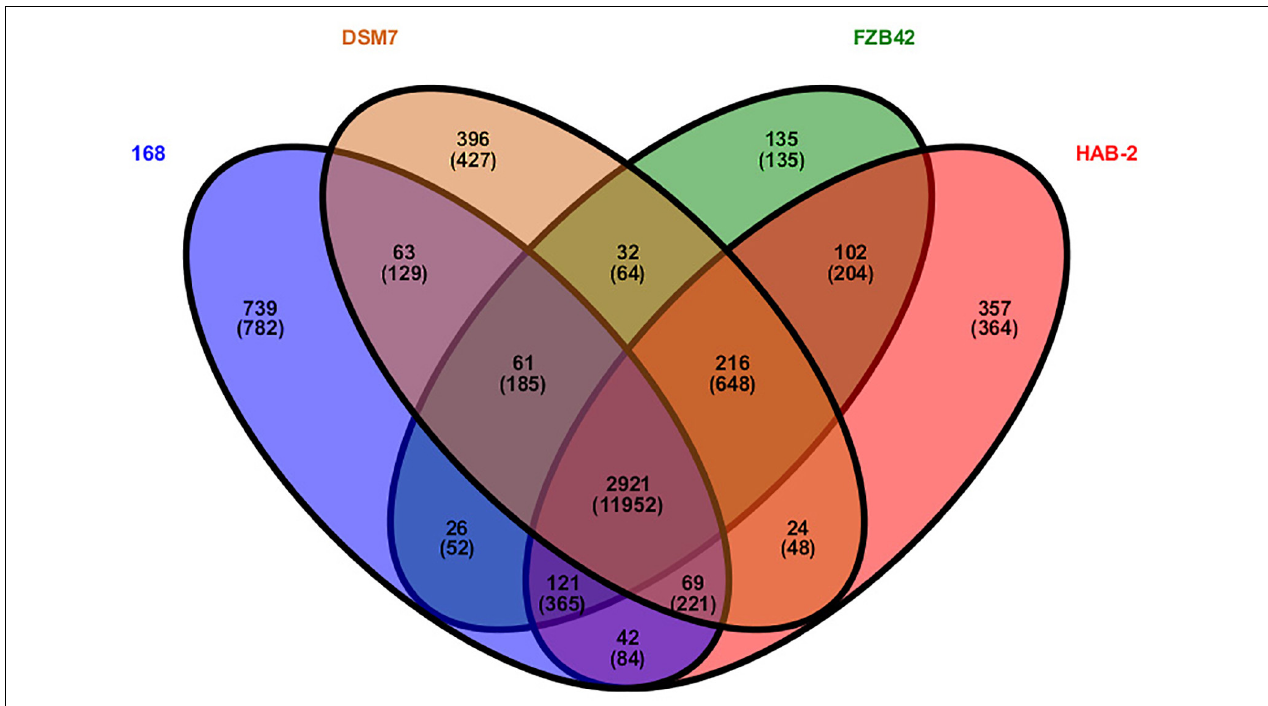
FIGURE 4 | Venn diagram showing the distribution of orthologous gene families in the genomes of B. velezensis HAB-2, B. velezensis FZB42, B. amyloliquefaciens DSM7 and B. subtilis 168. This analysis exploits all CDS of the genomes and is not restricted to the core genome. The number above each part represents the number of gene families, while the number below (in parentheses) represents the number of